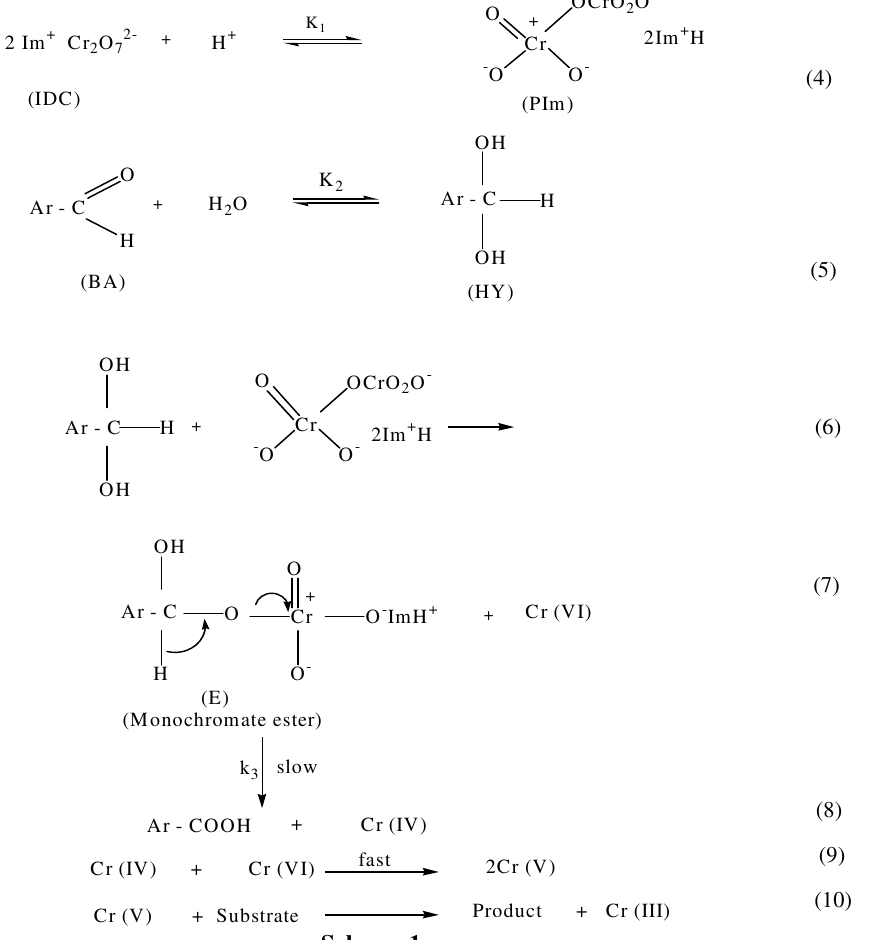
Table 3 . Second-order rate consents and activation parameters for the oxidation of benzaldehyde and some para -substituted benzaldehydes by